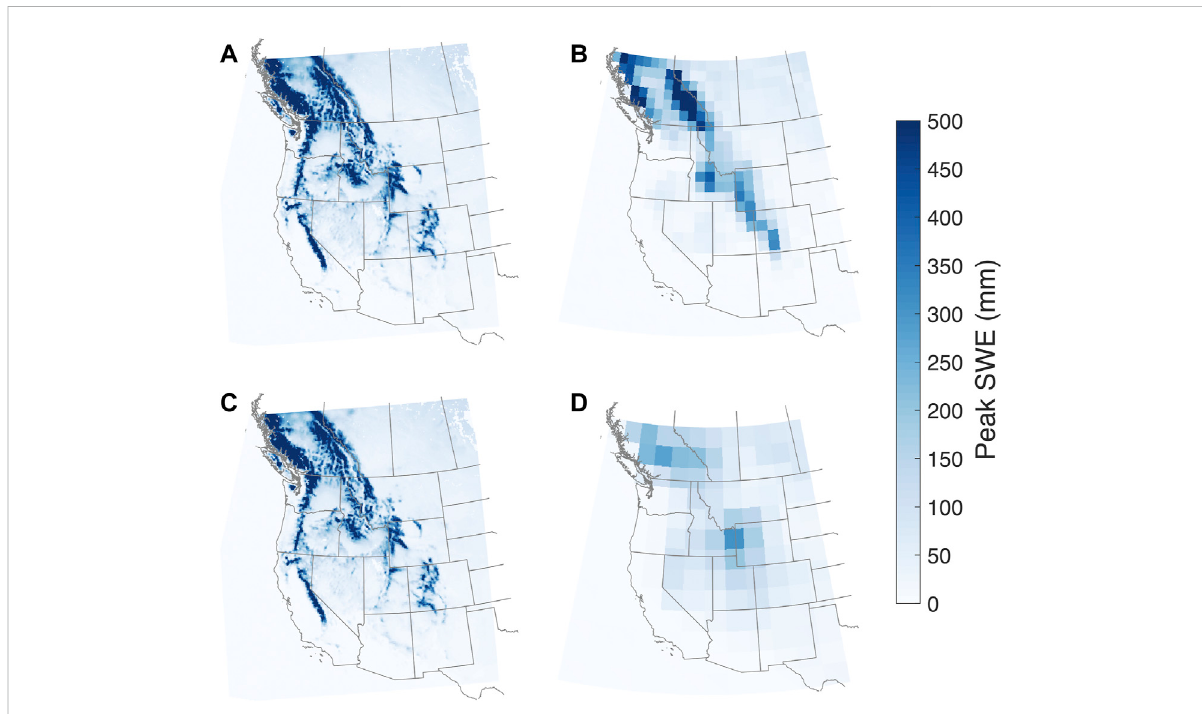
FIGURE 3 As for Figure 1 but for peak snow water equivalent. (A – D) represent WRF/CCSM4, CCSM4, WRF/NorESM1-M, and NorESM1-M,